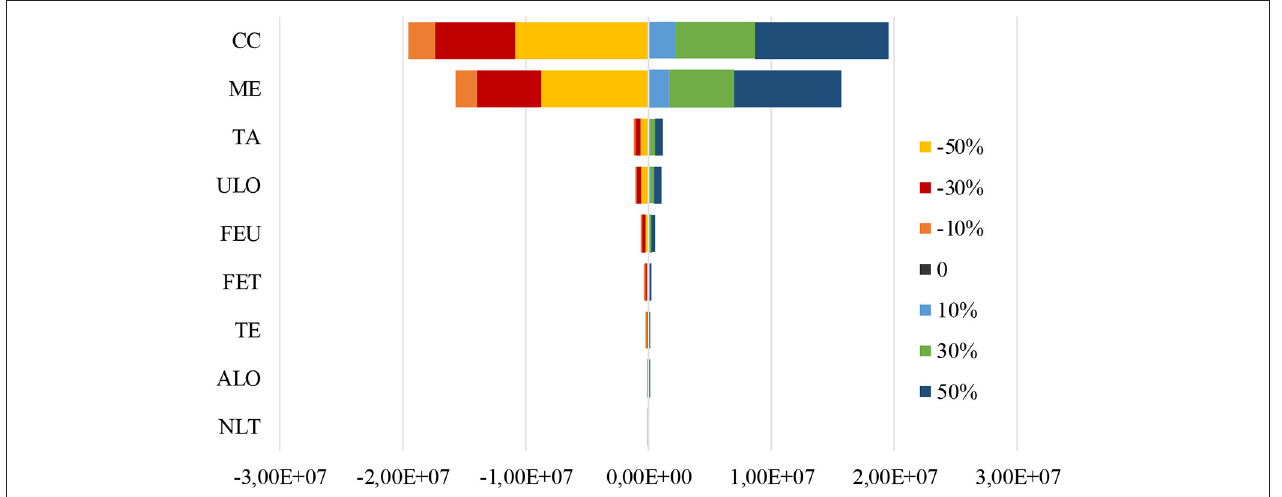
FIGURE 5 | Results of sensitivity analysis across environmental impact categories due to change in material quantity in production